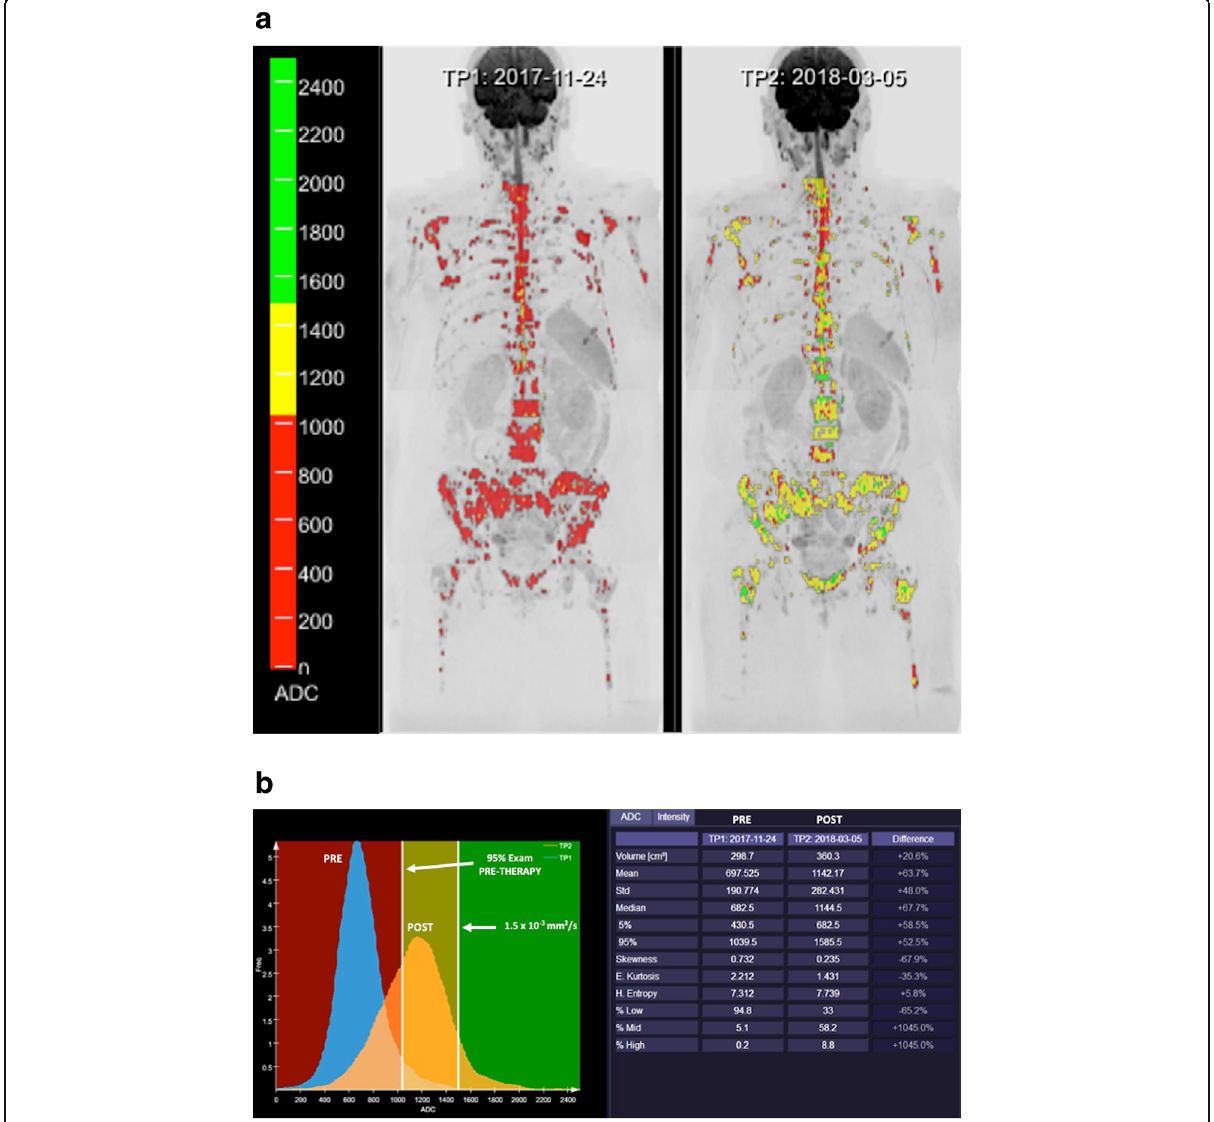
Fig. 7 A 63-year-old woman with metastatic breast cancer treated with an anti-HER2 agent and hormonotherapy. a Whole body diffusion- weighted inverted gray-scale maximun intensity projection (MIP) of b = 900 s/mm 2 images superimposing the ADC values associated with each voxel in color scale before (left) and after one cycle of therapy (right). Red colored voxels represent untreated disease or those with no-detectable response. The yellow voxels lie between the 95th centile value of the pre-treatment histogram and 1500 μ m 2 /s. Thus, yellow voxels represent regions “ likely ” to be responding. Green colored voxels have ADC values ≥ 1500 μ m 2 /s representing voxels that are “ highly likely ” to be responding with tumor cell kill. In this case, response assessment demonstrated a discrete change in ADC values (predominantly yellow voxels). b The detailed ADC analysis of histogram metrics evidenced an increased tumor volume with moderate changes in several histogram metrics (mean ADC, kurtosis, etc.) suggesting an apoptotic effect of targeted therapies (compare to Fig.